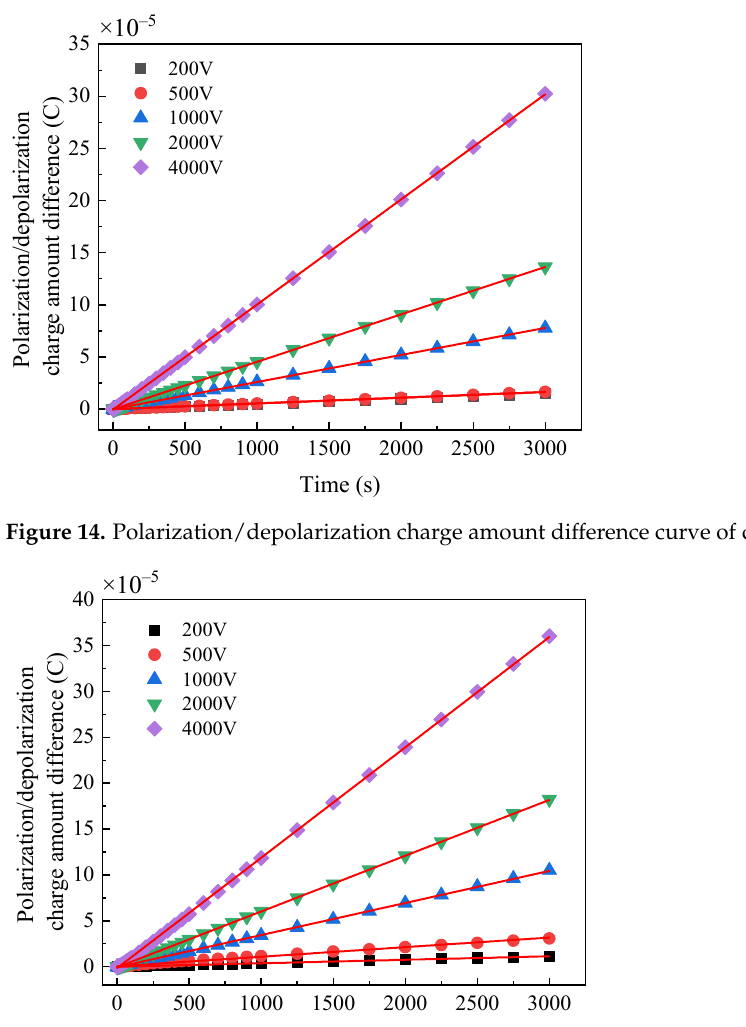
Figure 13. Polarization/depolarization charge amount difference curve of normal bushing.